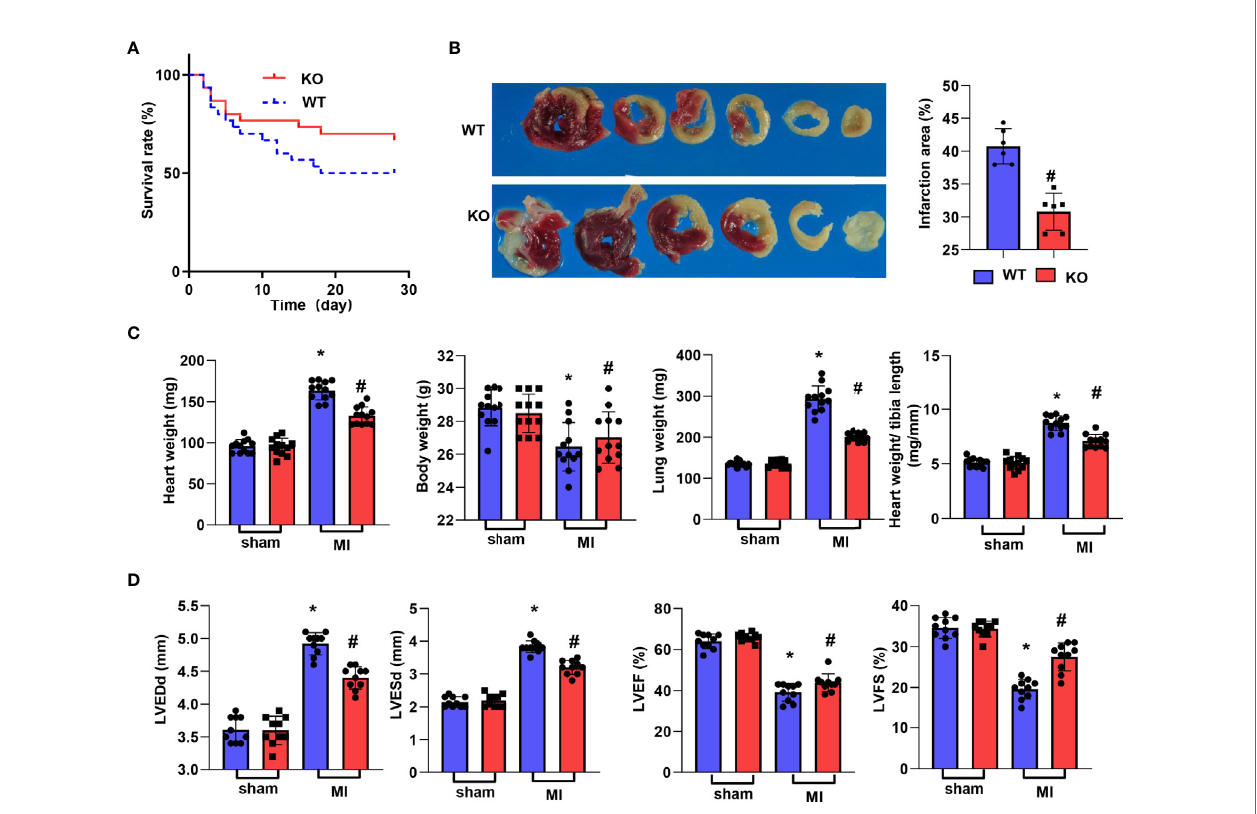
FIGURE 2 | CTRP1 de fi ciency reduces cardiac dysfunction post MI. (A) The survival rate of CTRP1 knockout mice at 28 days post MI (n=30 per group). (B) TTC staining and quanti fi cation of the infarct area (n=6). (C) Heart, body, and lung weights in mice at 28 days post MI (n=12). (D) Echocardiography of mice at 28 days post MI (n=10). * P <0.05 vs. the WT-sham group. # P <0.05 vs. the WT-MI